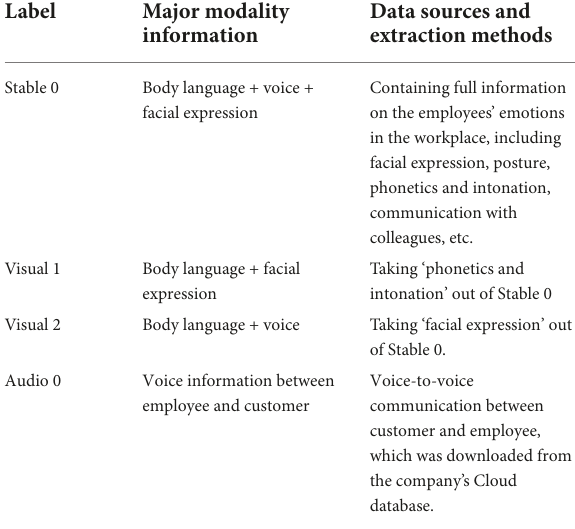
TABLE 6 Composition and interpretation of multimodal emotional database.